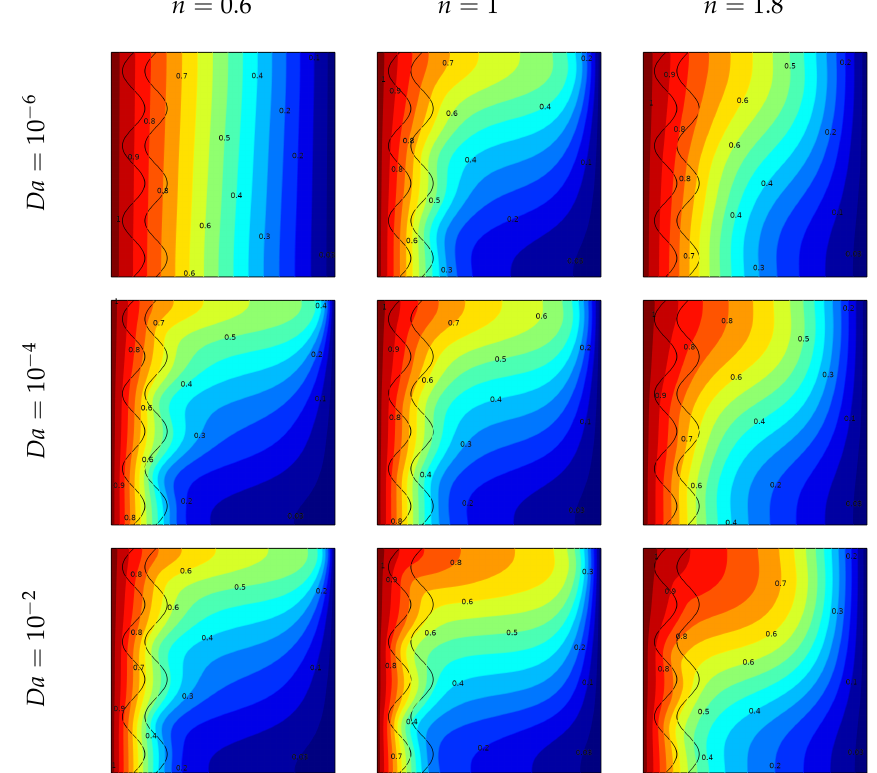
Figure 6. Isotherms for different values of power law indices n and Darcy numbers Da